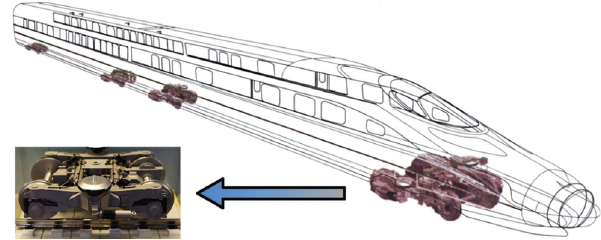
Figure 1: The bogie units of the high-speed